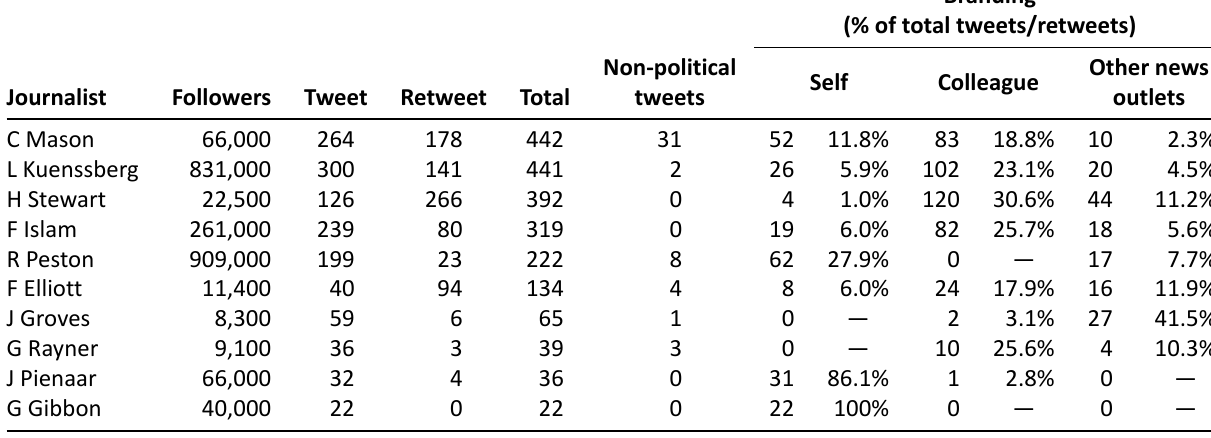
Table 2. Twitter